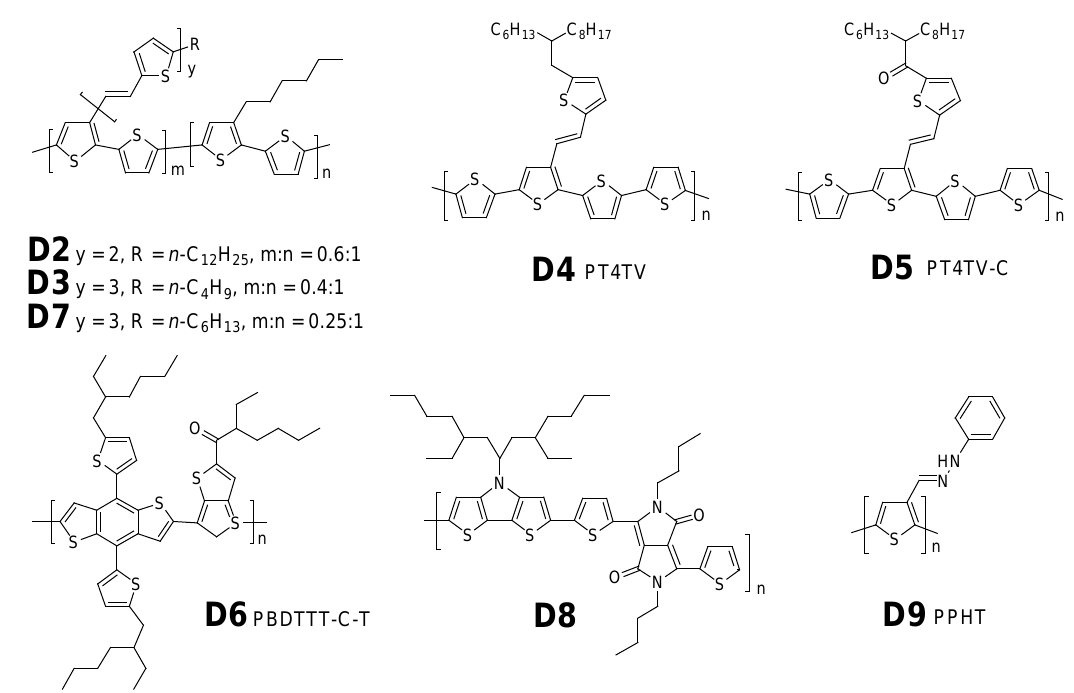
Figure 3. Molecular structures of polymer donors ( D2 – D9